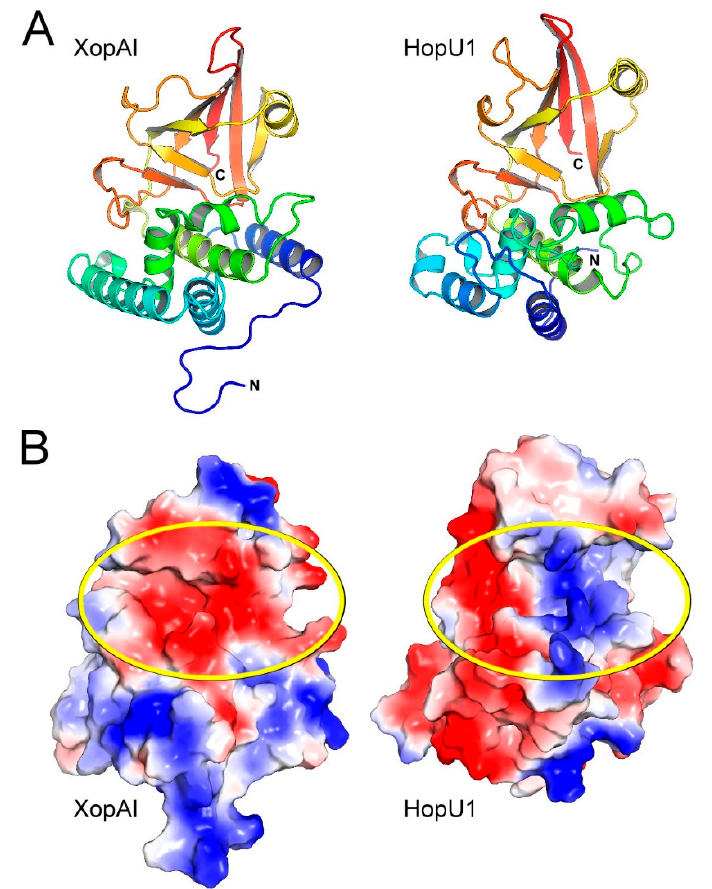
Figure 2. Structural comparison between XopAI and HopU1. ( A ) Ribbon diagram showing XopAI and HopU1 from Pseudomonas syringae . The structures are colored in the rainbow scheme. ( B ) Comparison of electrostatic surface of XopAI and HopU1. The regions of negative and positive potential are shown in red and blue, respectively; uncharged and hydrophobic surface areas are colorless. The central cleft on XopAI and the ADP-ribosylation site on HopU1 are marked with yellow ovals.